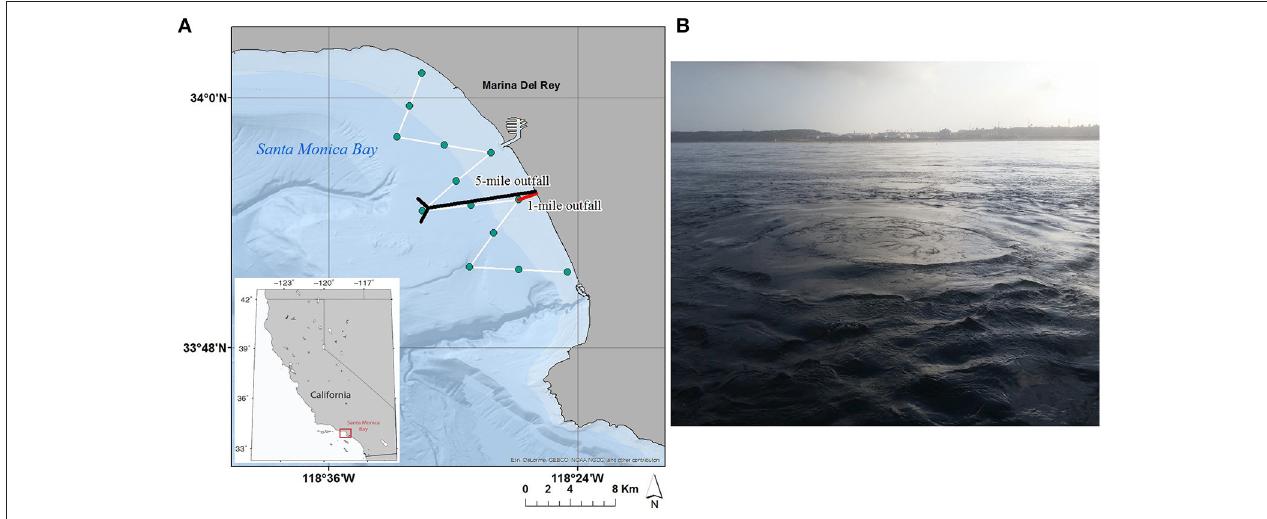
FIGURE 1 | (A) Map of Santa Monica Bay, California, with the 5-mile and 1-mile outfall pipes denoted as black and red lines, respectively, and in situ sampling stations denoted as green circles. (B) Photo of the wastewater plume surfacing at the terminus of the 1-mile outfall pipe during the